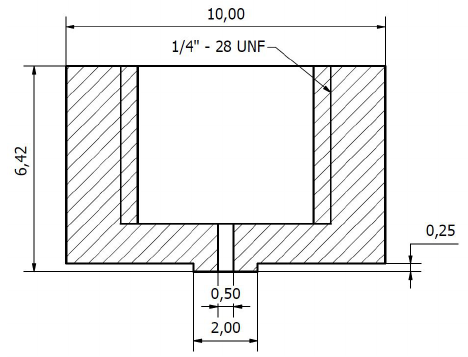
Figure 7. Updated design of the liquid connection device (dimensions in